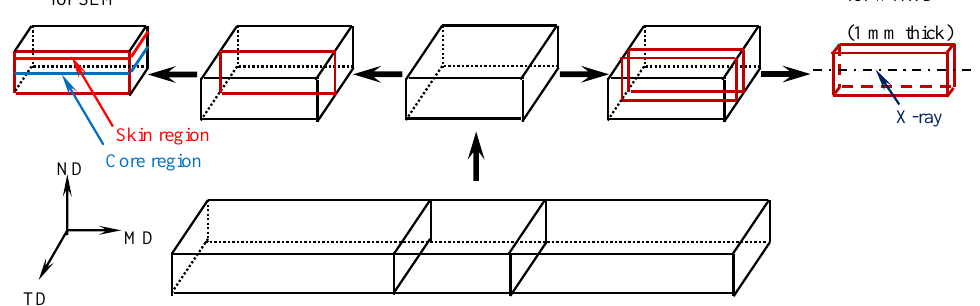
Figure 1. Schematic drawing of preparation of specimens for SEM and WAXD characterization: MD, the molded direction (i.e., flowing direction); TD, the transverse direction; ND, the direction normal to the MD-TD plane.